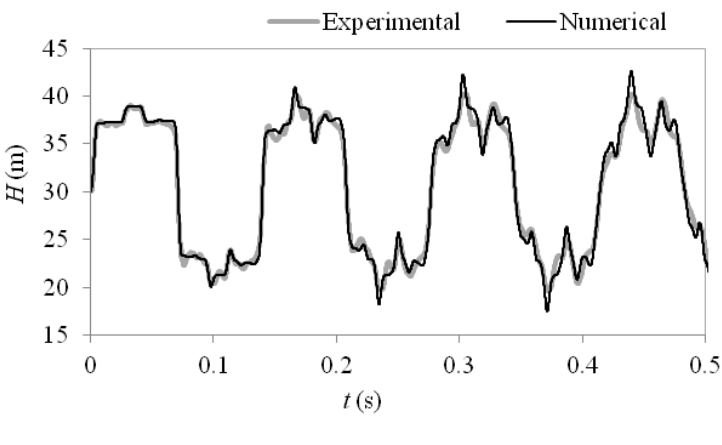
Figure 3. Comparison between numerical and experimental pressure responses for a pipeline with a thick walled